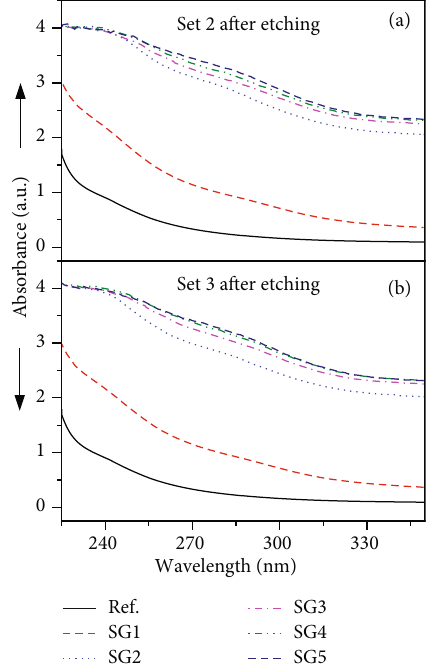
Figure 4: Absorption spectra of (a) set 2 and (b) set 3 after etching at 70 ° C for 3